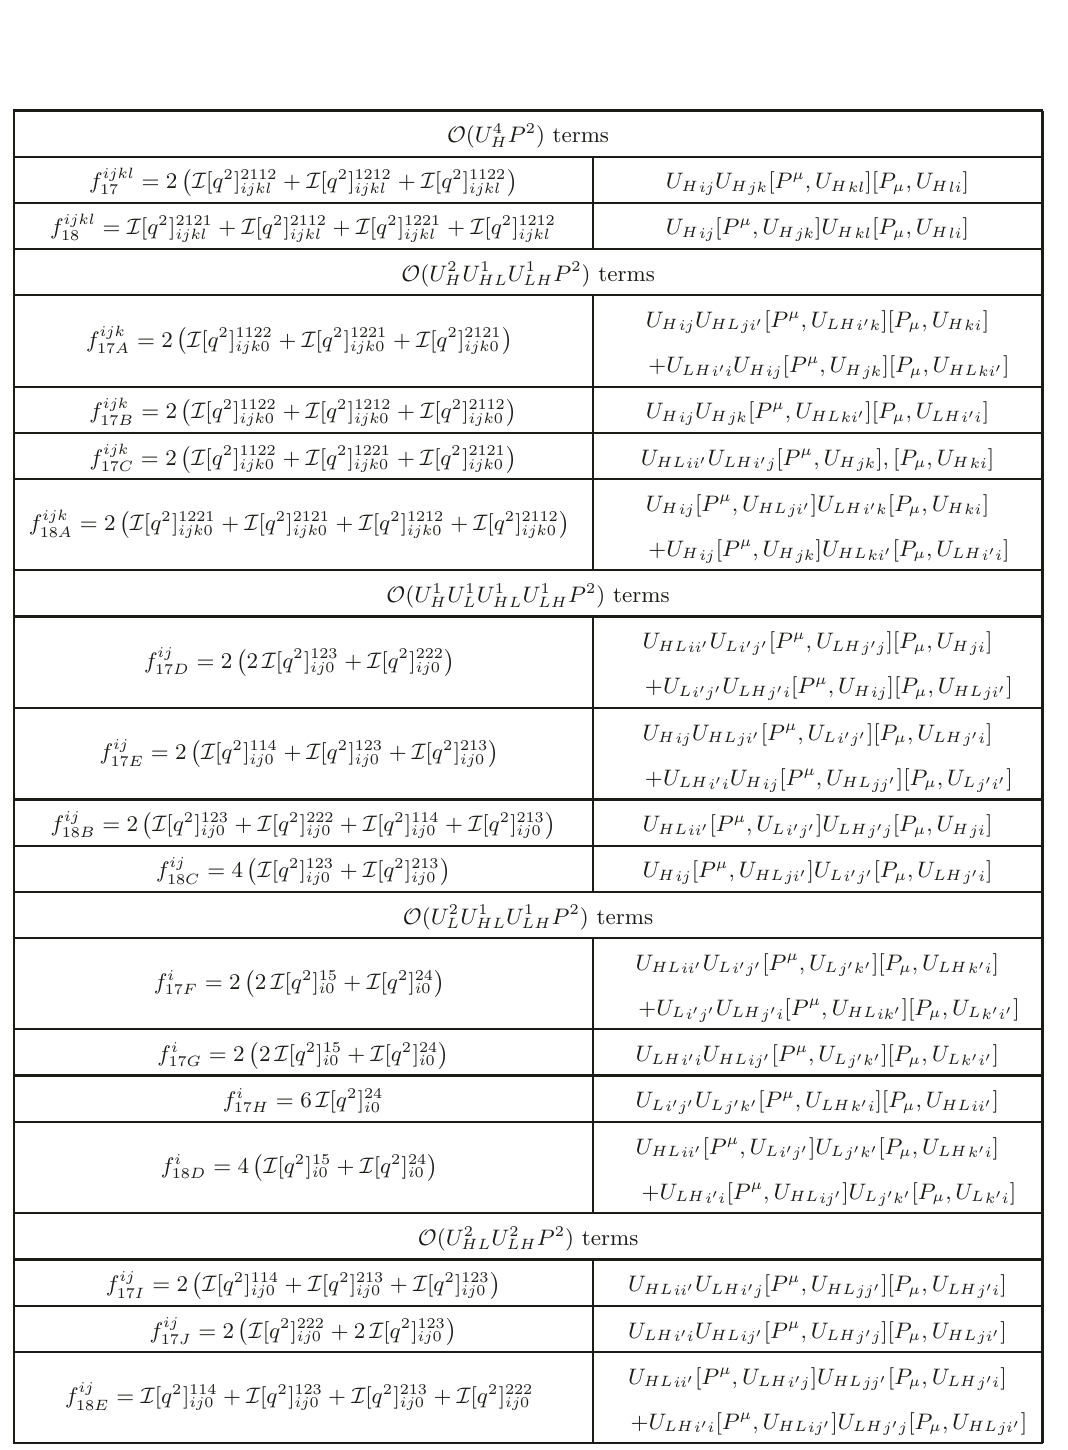
Table 4 . Universal coefficients f ijkl f ij for operators at O ( U 4 P 2 ). There are 17 terms: 2 heavy-heavy ones, 3 groups of 4 heavy-light 18 E terms, and 1 group of 3 heavy-light